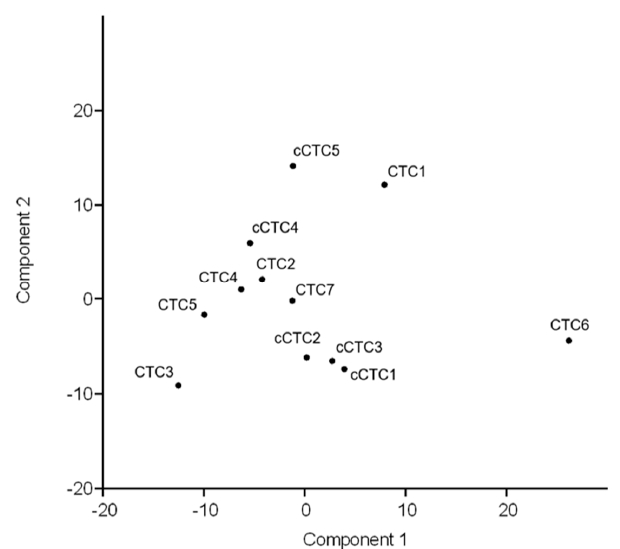
Figure 6. Combined gene expression analysis of single uncultured and cultured CTCs. PCA showed no clear distinction, but rather showed a partly combined grouping of CTCs ( n = 7) and cCTCs ( n = 5). Uncultured CTCs are distributed to a greater extent.